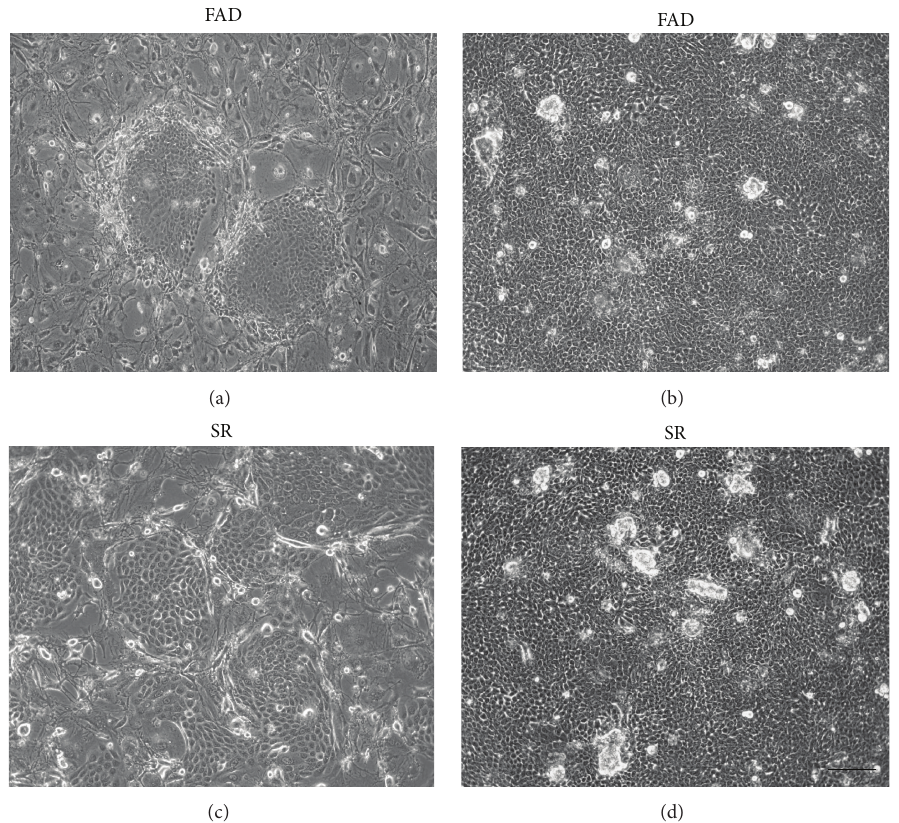
Figure 1: The culture of human limbal epithelial cells in SR medium. (a) The human corneal epithelial cells formed tightly compacted colonies in FAD medium after seeding cells for 3 days. (b) After 7 days, epithelial cells reached confluence in FAD medium with uniform small size. (c) Human corneal epithelial cells formed colonies within SR medium, which were similar to those formed within FAD medium, but these colonies were less tightly compacted than those in FAD. (d) After 7 days, epithelial cells reached confluence in SR medium with uniform small size which was similar to those in FAD culture Original magnification: (a) × 10; (b) × 10 (scale bars: 100 𝜇